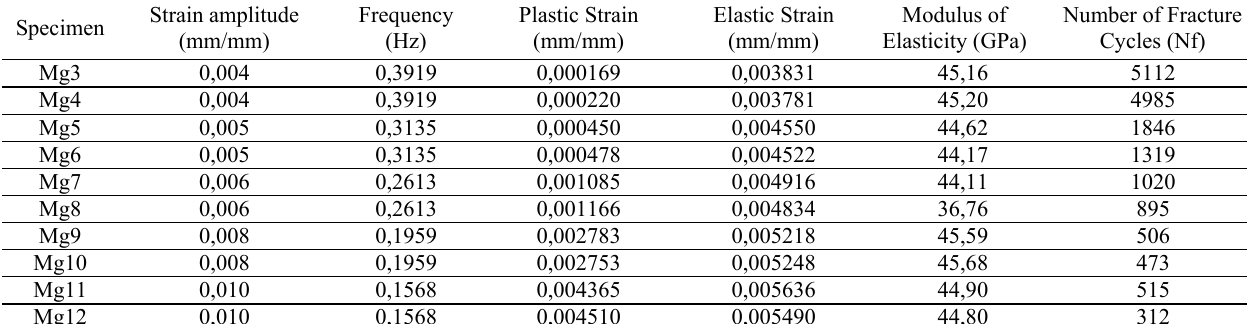
Table 3. Low cycle fatigue test results of Mg AZ31B